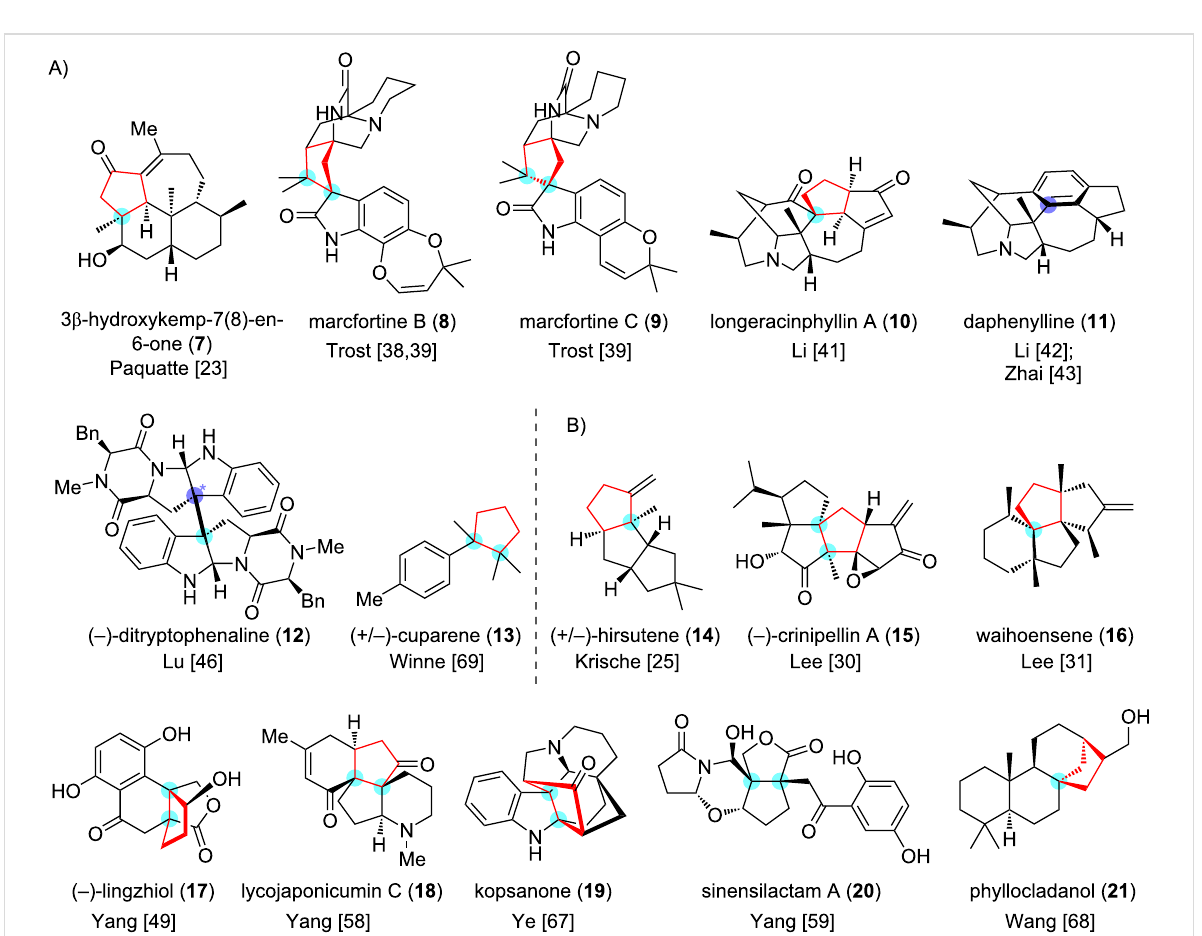
Figure 2: Natural product synthesis featuring the all-carbon [3 + 2] cycloaddition. (Quaternary carbon center(s) created by all-carbon [3 + 2] cycliza- tion are highlighted in cyan; quaternary carbon center(s) created that are removed by subsequent transformations are highlighted in lilac; cyclopen- tane structures forged by the all-carbon [3 + 2] cyclization are labeled in red). (A) The intermolecular all-carbon [3 + 2] cyclization features as the key reaction. (B) The intramolecular all-carbon [3 + 2] cycloaddition features as the key